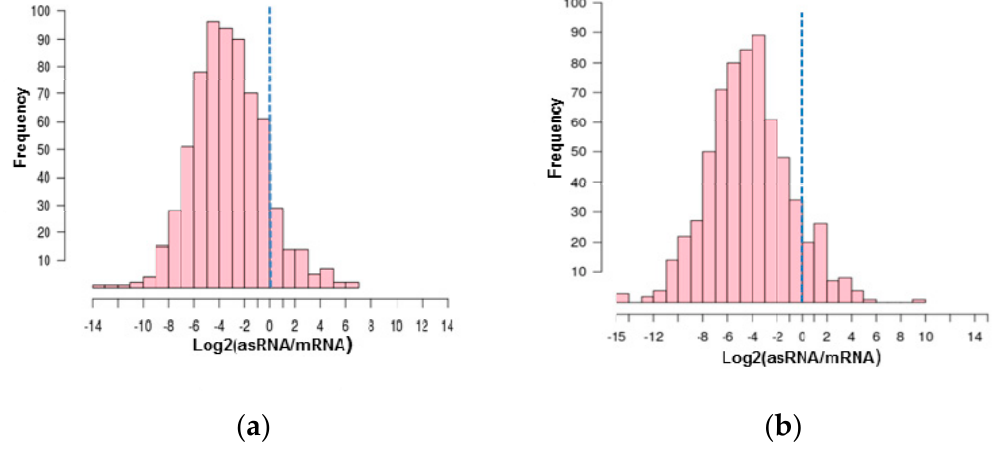
Figure 3. Relative expression levels of asRNAs and messenger RNA (mRNAs) on the opposite strand for arbitrarily selected representative libraries: ( a ) stationary phase (17 h) and ( b ) gas vesicle release phase (86 h). Vertical dotted lines mark 1:1 expression levels. Expanded version in Figure S5.